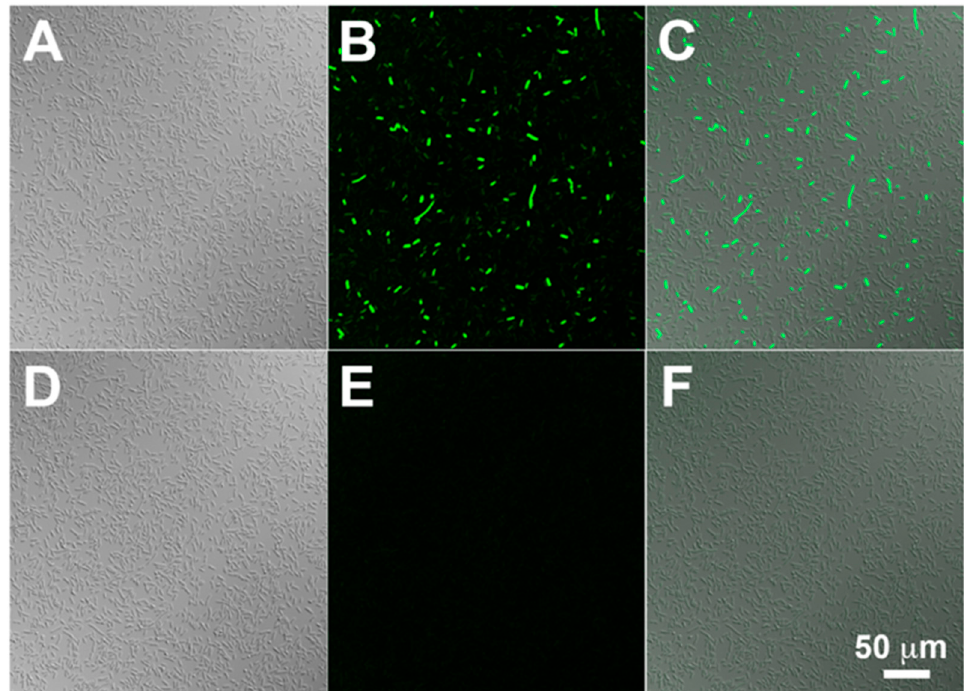
Figure 3. Stereo-preference of living E. coli cells for fluorescence-emitting D -glucose tracer 2-NBDG ( A – C ) over L -glucose tracer 2-NBDLG (D-F) [112]. ( A ) and ( D ), differential interference contrast images. ( B ) and ( E ), fluorescence images after administration of the fluorescence-emitting D - and L - glucose tracers, respectively. ( C ) and ( F ) are merged images. Images were taken for E. coli DH-5 α TM cells under the same condition by a confocal microscope (TCS-SP5, Leica) at excitation and emission wavelengths of 488 nm and longer than 500 nm, respectively. The scale bar is common to all panels (Images were taken by Drs. Katsuhiro Nagatomo and Katsuya Yamada, Hirosaki University Graduate School of Medicine).